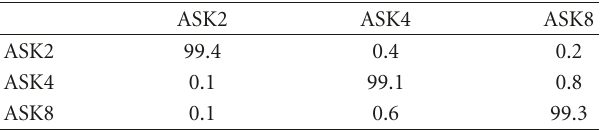
Table 6: Confusion Matrix at SNR = − 4 d B.